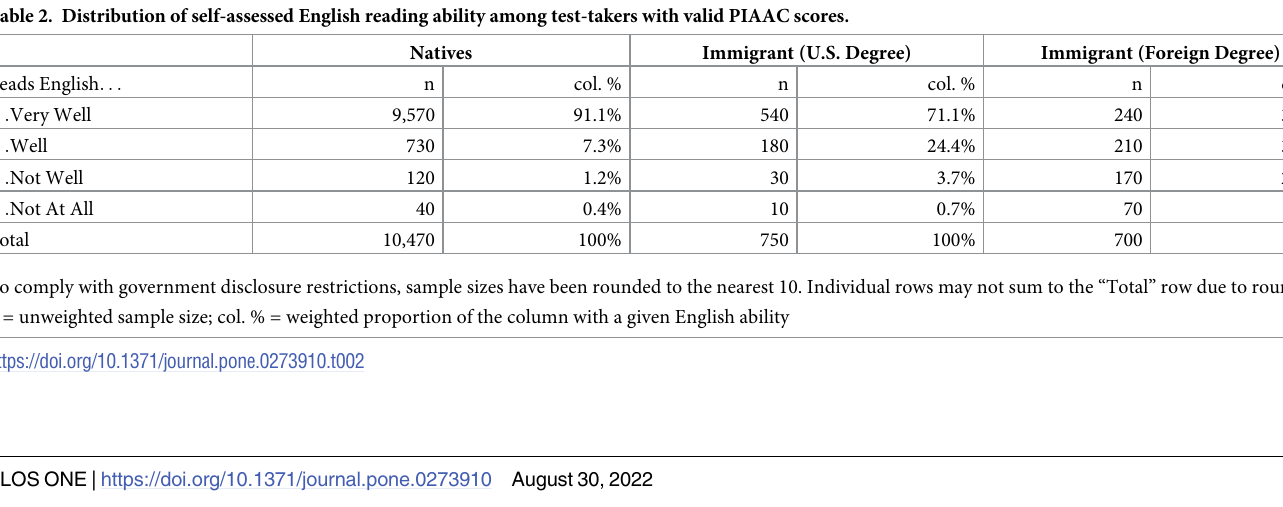
Table 2. Distribution of self-assessed English reading ability among test-takers with valid PIAAC scores. Reads English